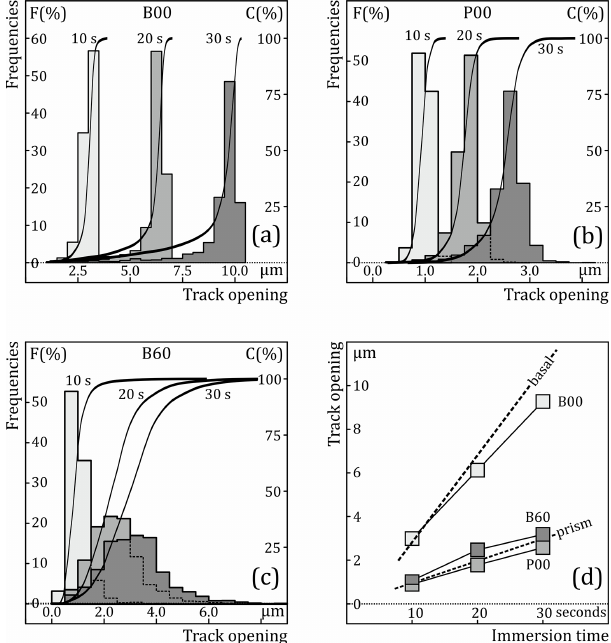
Figure 4. Histograms and cumulative frequencies ( g spectra, Jon- ckheere et al., 2020) of the sizes (long axes) of the track openings in (a) a basal face, (b) a prism face and (c) a face at 30 ◦ to a prism face of Durango apatite after 10, 20 and 30s etching (5.5M HNO 3 at 21 ◦ C); (d) the mean sizes plotted against etch time show a constant rate of increase in the three surfaces; the dashed lines are predicted trends assuming an initial accelerated etching of 0.15µm in